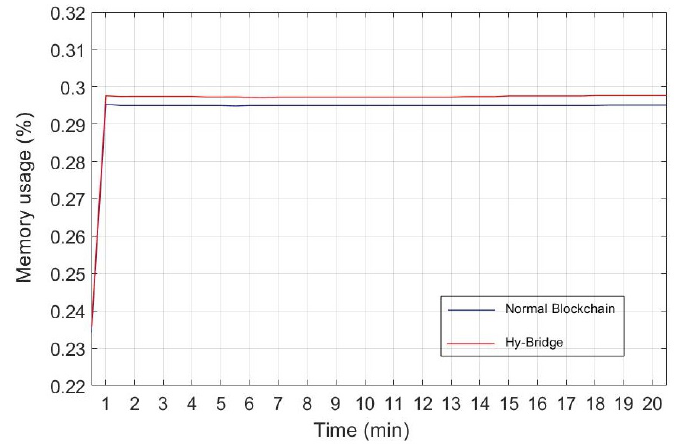
Figure 9. Memory percentageused by Hy-Bridge and the normal blockchain based on IoT power consumption presented in Table